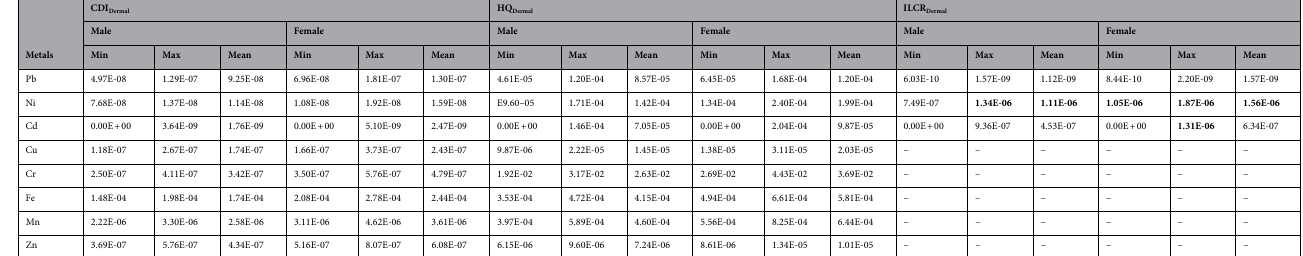
Table 6. Calculated chronic daily intake (CDI), hazard quotients (HQ) and incremental lifetime cancer risk (ILCR) values for male and female due to dermal exposure of trace metals to the soils of brinjal-producing areas of Jamalpur district, Bangladesh. Bold ILCR Dermal values indicates the cancer